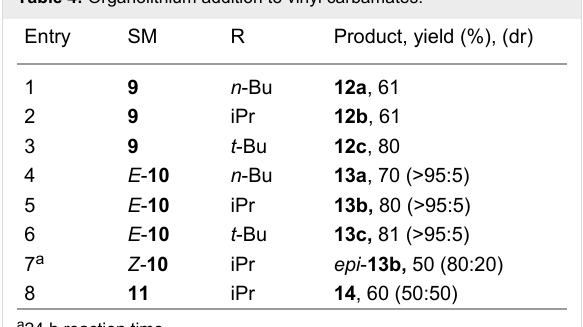
Table 4: Organolithium addition to vinyl